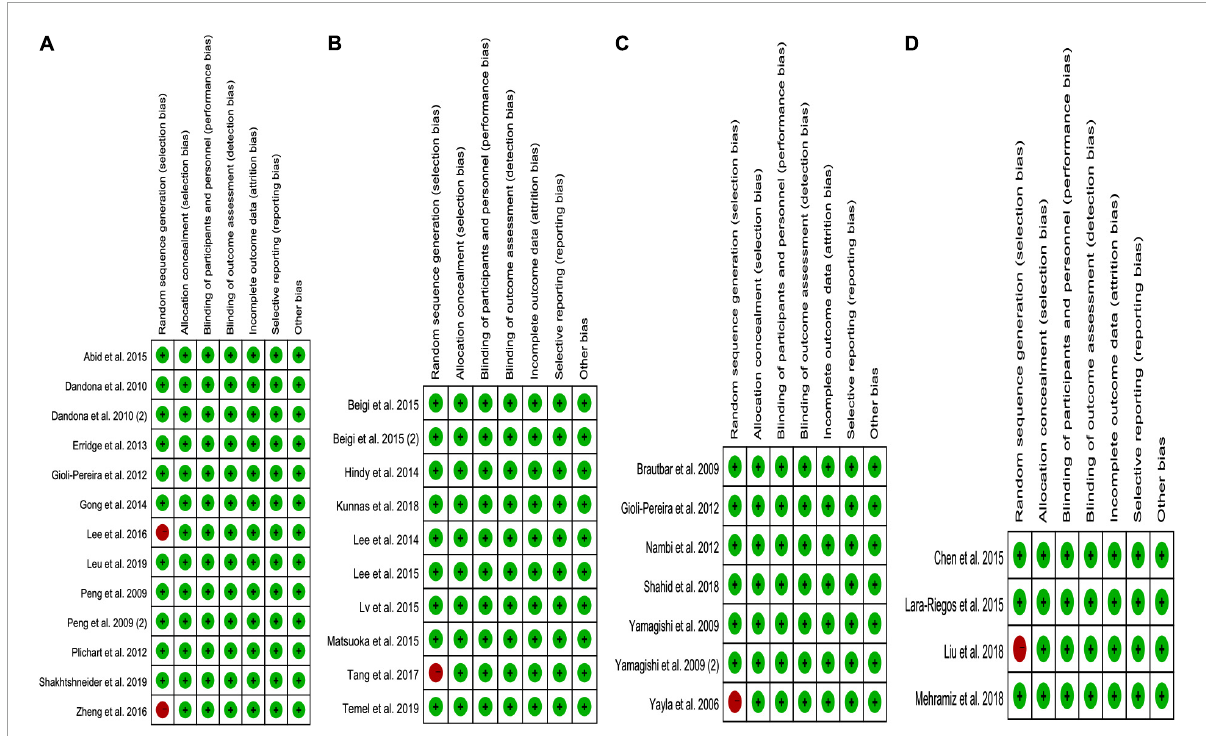
FIGURE6 The risk bias plot of lncRNA variant with circulating lipid levels [ (A) rs1333049 with TG; (B) rs4977574 with LDL-C; (C) rs10757274 with HDL-C; and (D) rs10811661 with LDL-C].